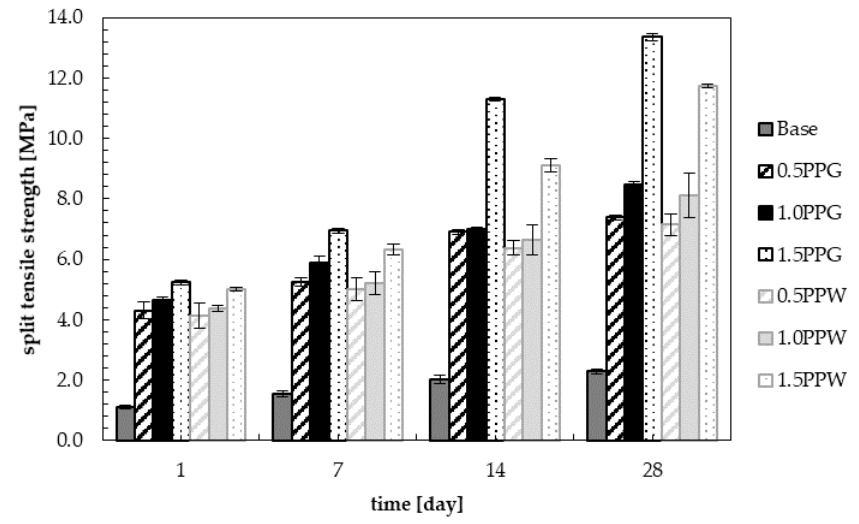
Figure 16. Split tensile strength of samples with PPG and PPW during curing.